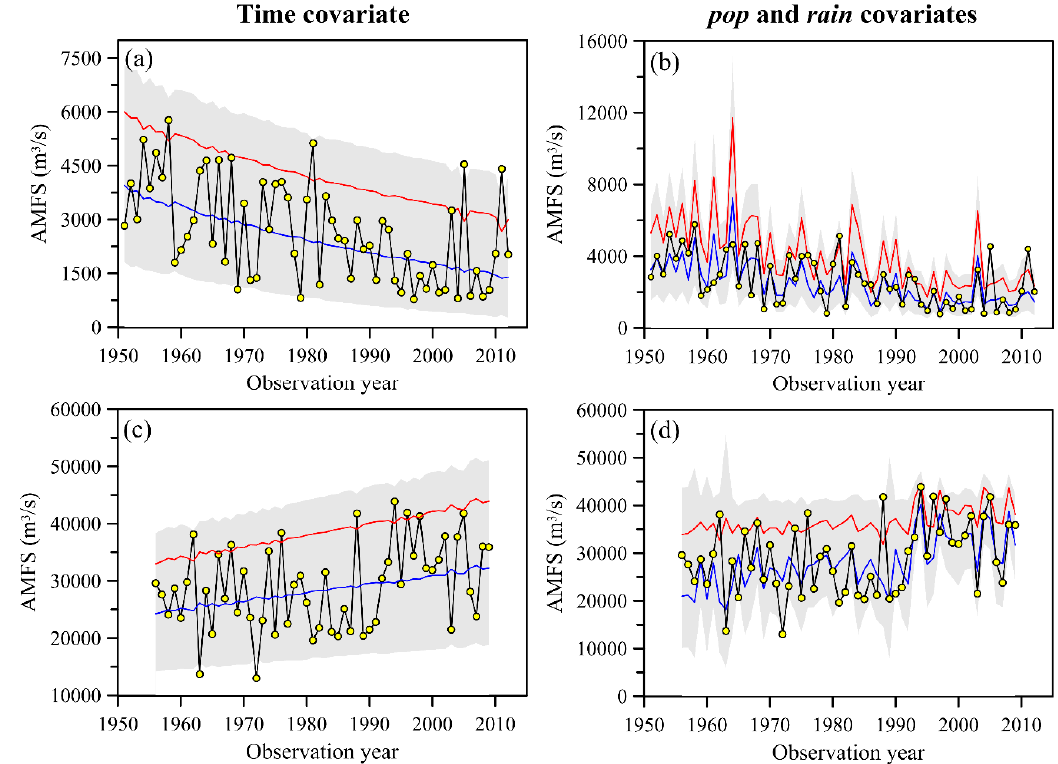
Figure 10. The cross-validated flood quantiles for Huaxian station ( a , b ) and Dahuangjiangkou station ( c , d ). The yellow points are the observed AMFS. The lower and upper bounds are the cross-validated flood quantiles associated with the 2.5th and 97.5th centiles, while the blue line and the red line are the cross-validated flood quantiles associated with the 50th and 90th centiles.